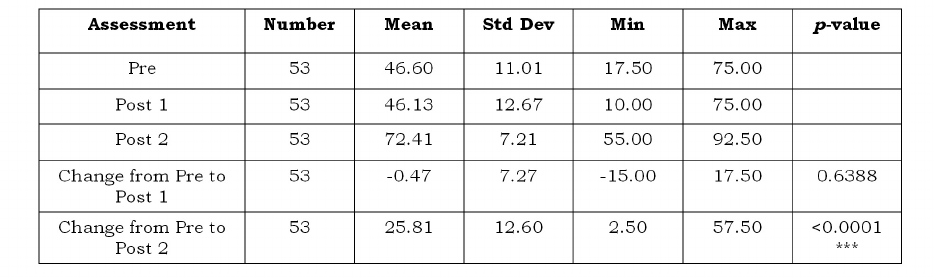
Table 8: Overall percentage knowledge scores of students: control group